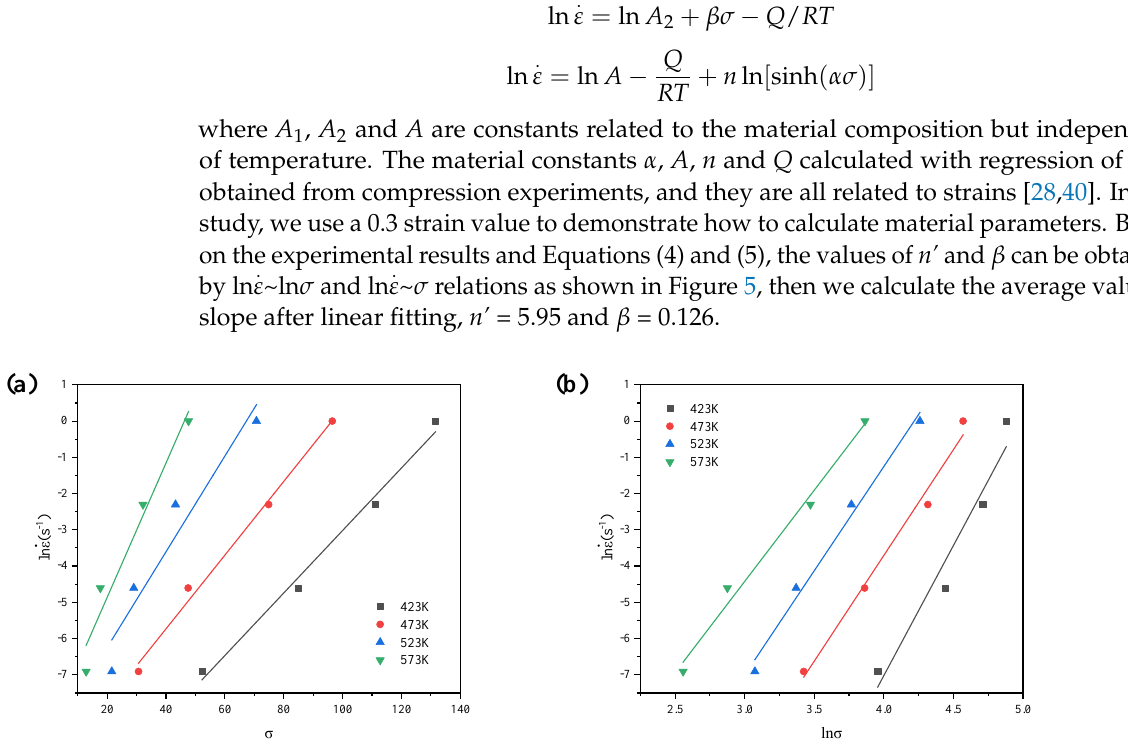
. . Figure 5. Linear fitting relationships at strain = 0.3: ( a ) ln ε ~ σ ; ( b ) ln ε ~ln σ . ~ σ ; ( b ) ln ~ln σ . Figure 5. Linear fitting relationships at strain = 0.3: ( a ) ln The equation of α = β /n’ can be used to obtain α = 0.02124. Then by doing partial 𝜀𝜀̇ 𝜀𝜀̇ derivatives of both sides of Equation (6), the equation can be rewritten as: Q = R . ε ~ln[sinh( ασ )] and ln[sinh( ασ )]~1000/ T As shown in Figure 6, the relationship between ln can be obtained by linear fitting at a given temperature and strain rate respectively. Take the average of line slopes in Figure 6a to get n = Q 1 = 4.1934, and similarly get Q 2 = 3.0241 in Figure 6b will allow us compute Q = R × Q 1 × Q 2 = 105.43 kJ/mol. Then based on Formula (6) and the average intercept values of lines in Figure 6a, we get ln A = 21.37, hence A = 1.9 × 10 9 . Thus, Equation (6) can be expressed as: